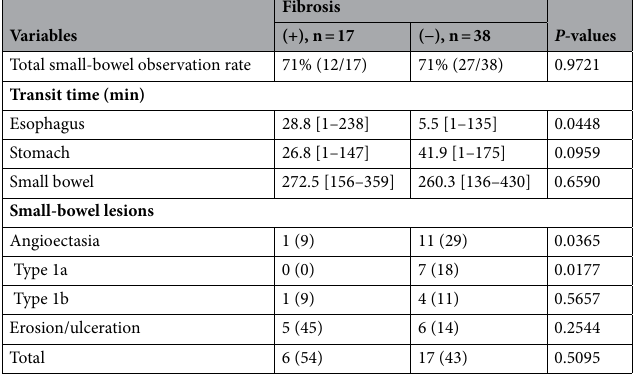
Table 5. The average capsule transit time and small-bowel lesions according to the presence of fibrosis in the gastrointestinal tract. Data are shown as frequencies (percentages) or means, as